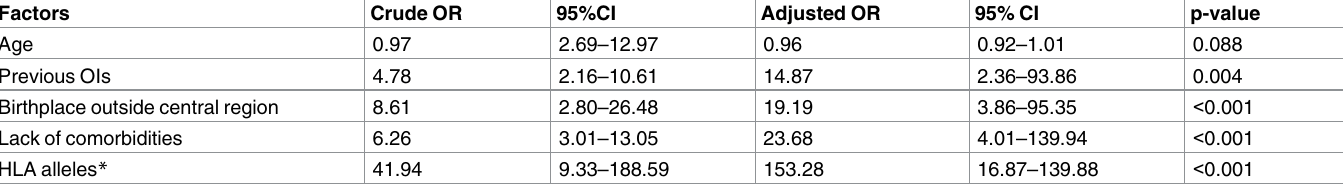
Table 3. Results of multivariate